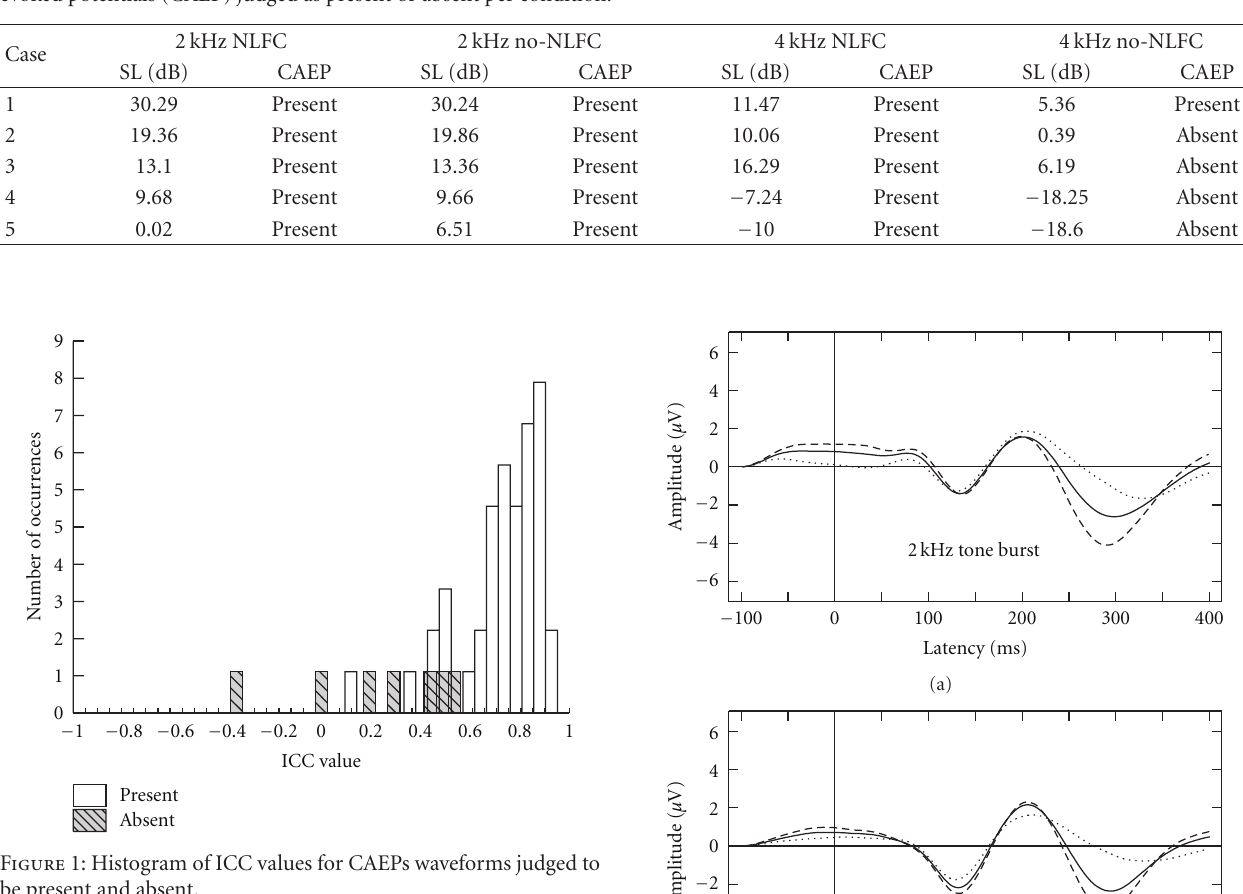
Table 1: Summary of electroacoustic verification results for all HI cases (1 through 5). Summaries are shown across stimuli (2kHz and 4kHz tone bursts) and hearing aid conditions (NLFC enabled and no-NLFC). Results are compared to the corresponding cortical auditory evoked potentials (CAEP) judged as present or absent per condition.